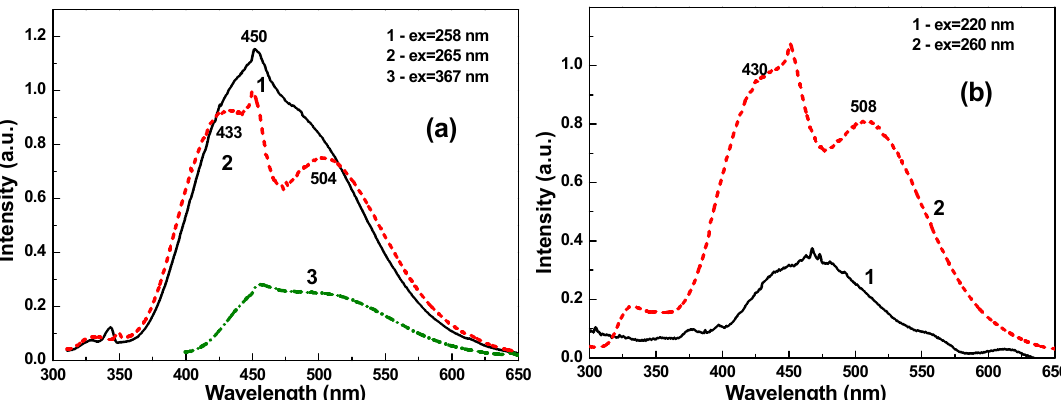
Figure 8. Luminescence spectra of CeAlO 3 eutectic structure ( a ) and colored spots at the surface of transparent CeAlO 3 single crystal and ( b ) under excitation with the different wavelengths in the UV range.